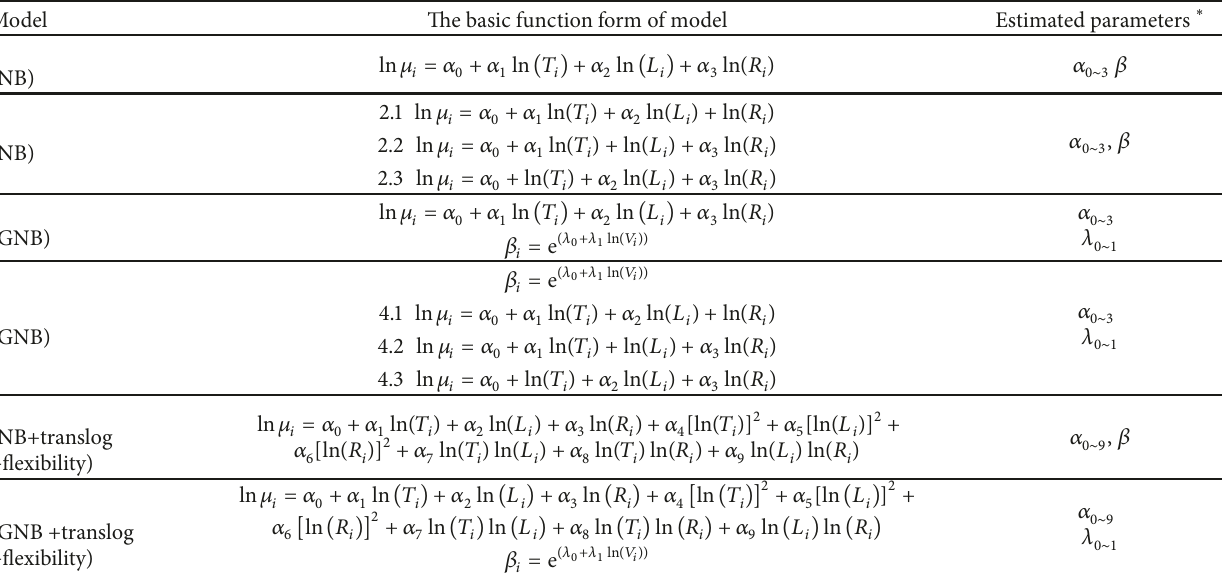
Table 3: Models and statistics